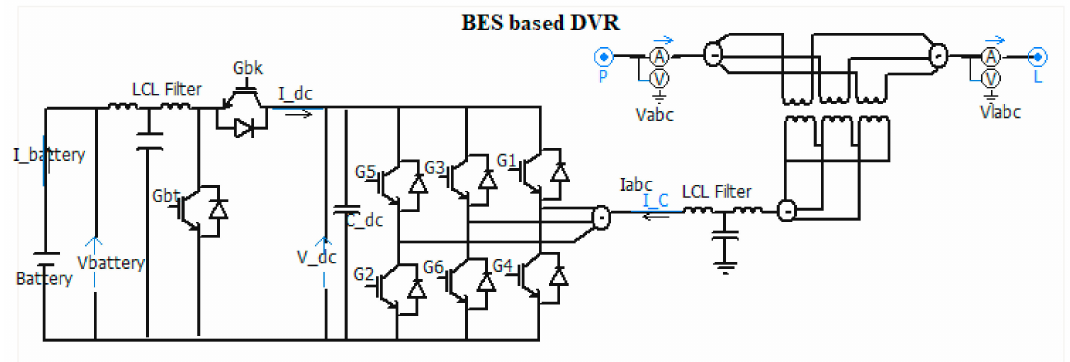
Figure 7. Detailed block diagram of BES-based